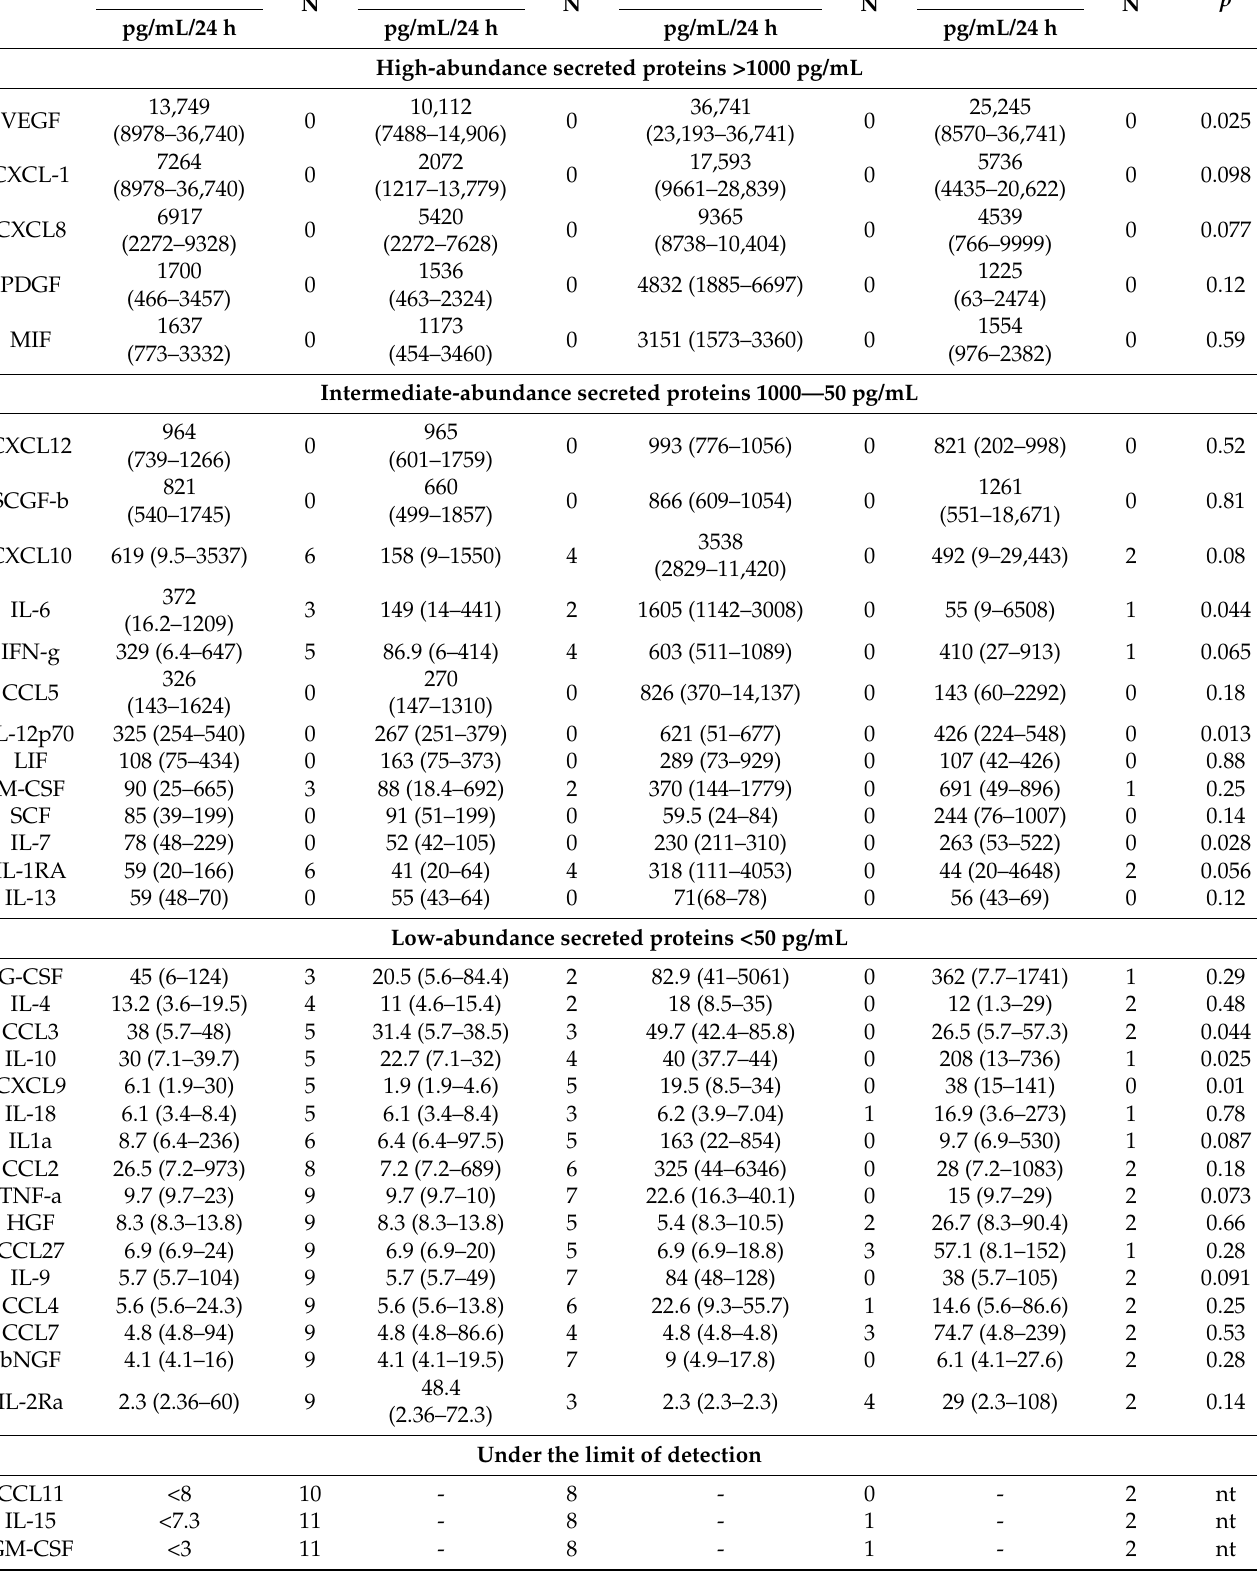
Table 1. Evaluation of secretome according to the different stemness